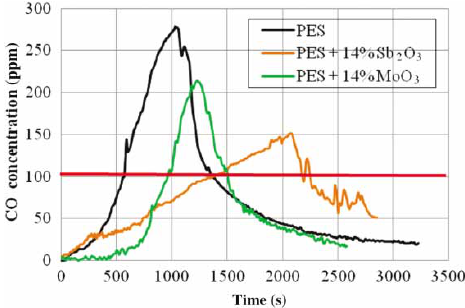
Fig. 10. CO concentration time series registered by A1 sensor located at the corner of the compartment (post A) at 1.6 m for three studied samples